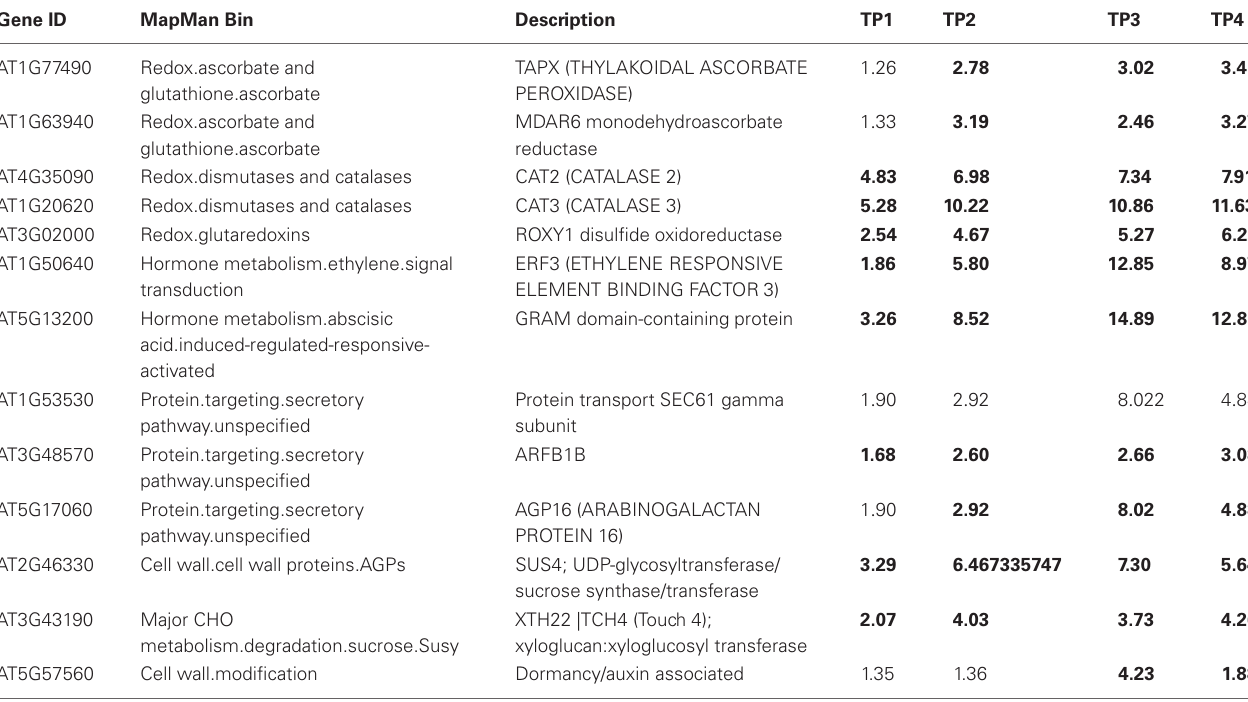
Table 4 | Genes with largest up-regulation over the time course of winter hardening. Gene